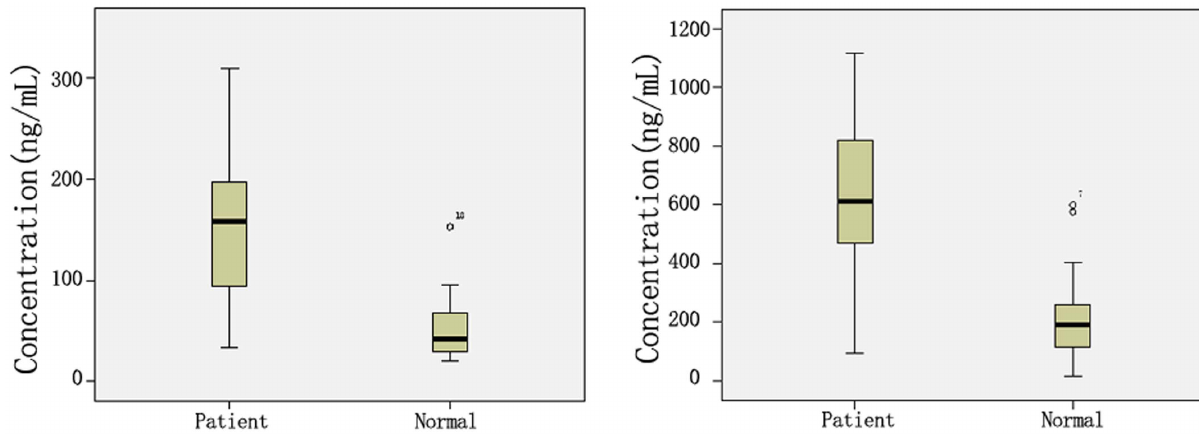
Figure 5. Expression of apoA1 and SAP in sera of lung cancer patients and healthy donors. doi:10.1371/journal.pone.0095121.g005 PLOS ONE |